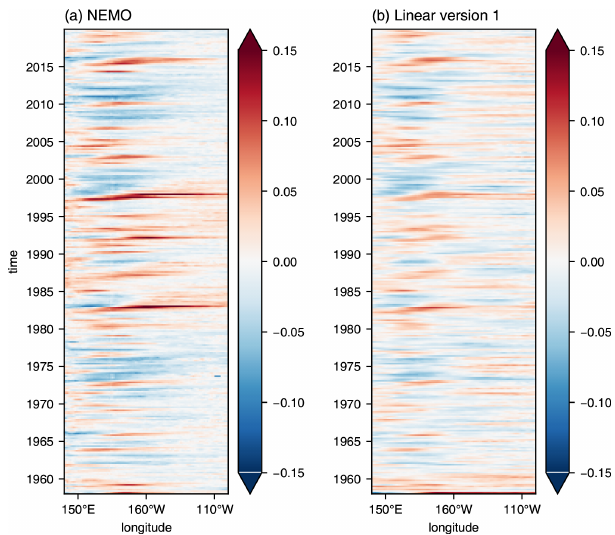
Figure 7. Hovmöller diagrams as a function of longitude along the Equator for (a) η nlti computed from the NEMO model simulation and (b) η nlti computed using Version 1 of the linear multi-mode model. The units are